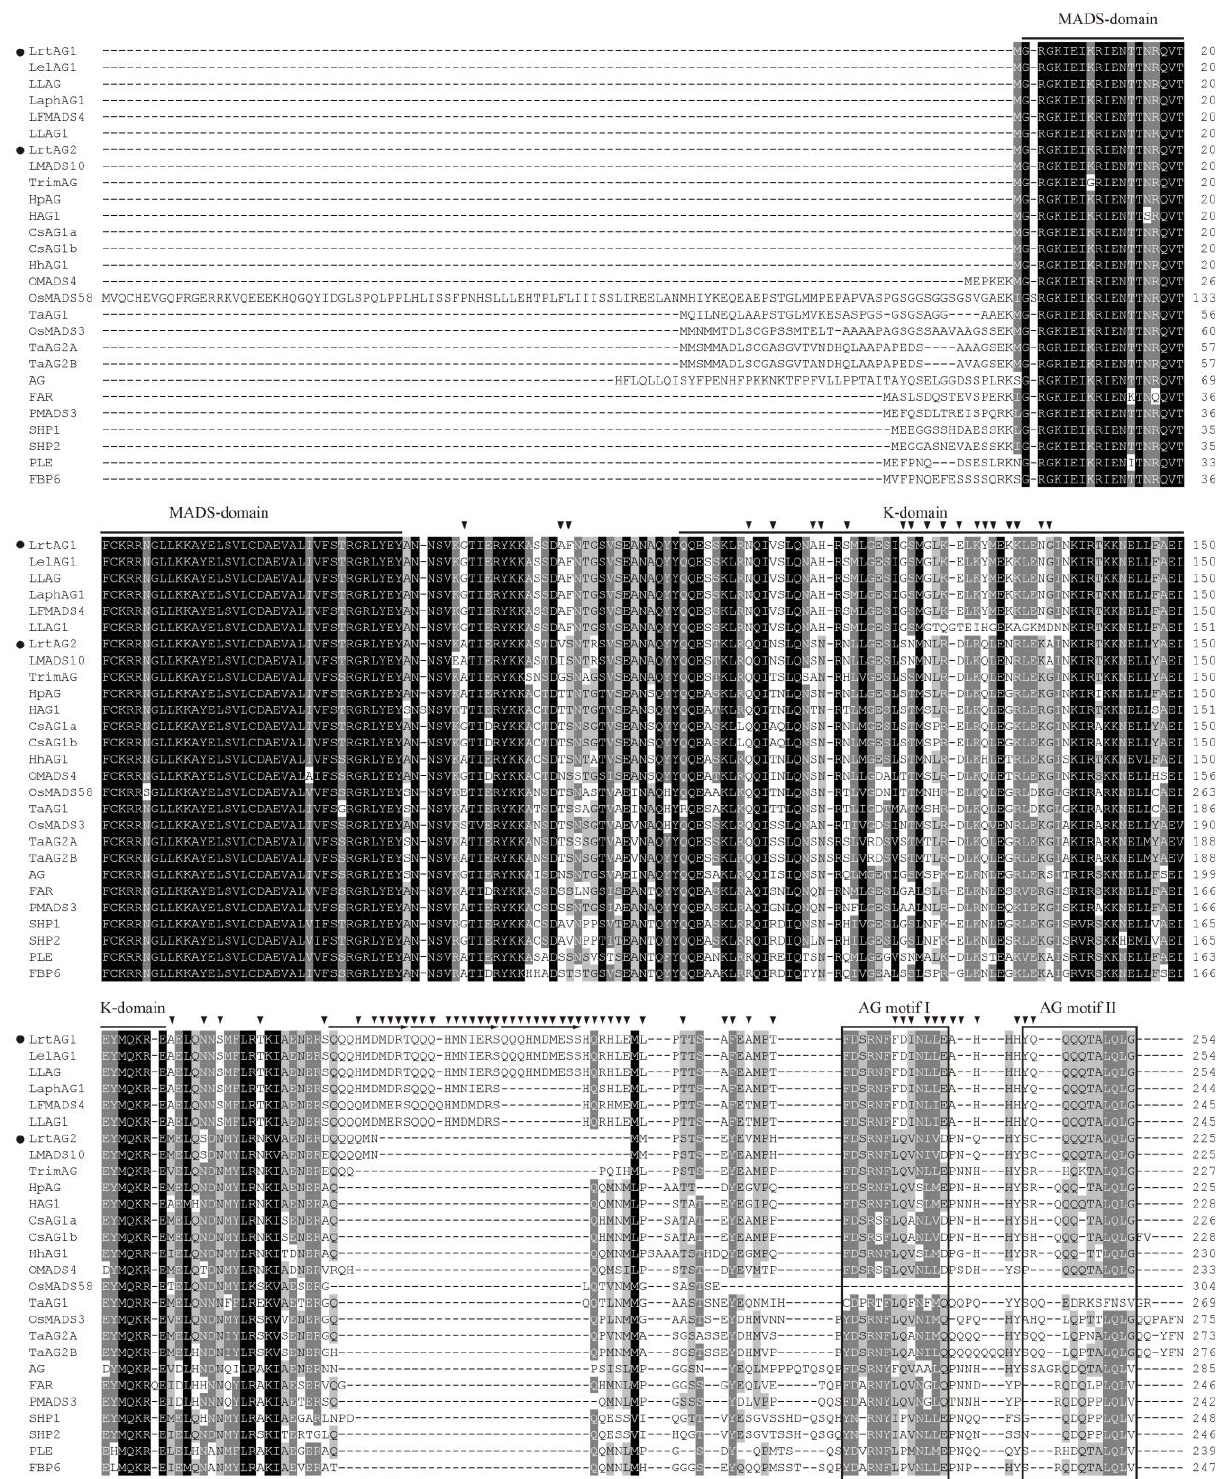
Figure 6. Comparison of amino acid sequences of LrtAG1, LrtAG2, and related C-class gene proteins in monocots and dicots. Identical amino acid residues of these proteins are in black, and conserved residues are in gray. Gaps (-) are introduced to maximize alignment. The amino acid positions are shown on the right. Black lines are drawn above the MADS- and K-domain. AG motif I and AG motif II are indicated by boxes. The repeat sequences are indicated by arrows. The prefixed black dots indicate LrtAG1 and LrtAG2, and the triangles indicate different amino acid sequences between LrtAG1 and LrtAG2.